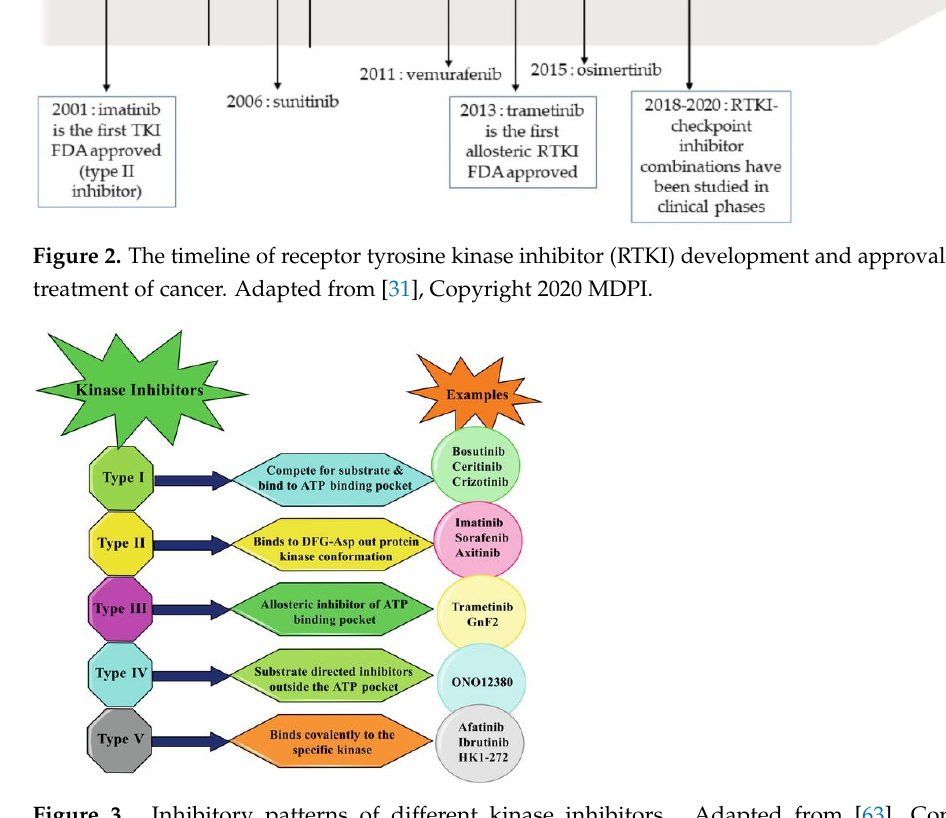
Figure 3. Inhibitory patterns of different kinase inhibitors. Adapted from [63], Copyright 2021 IntechOpen.